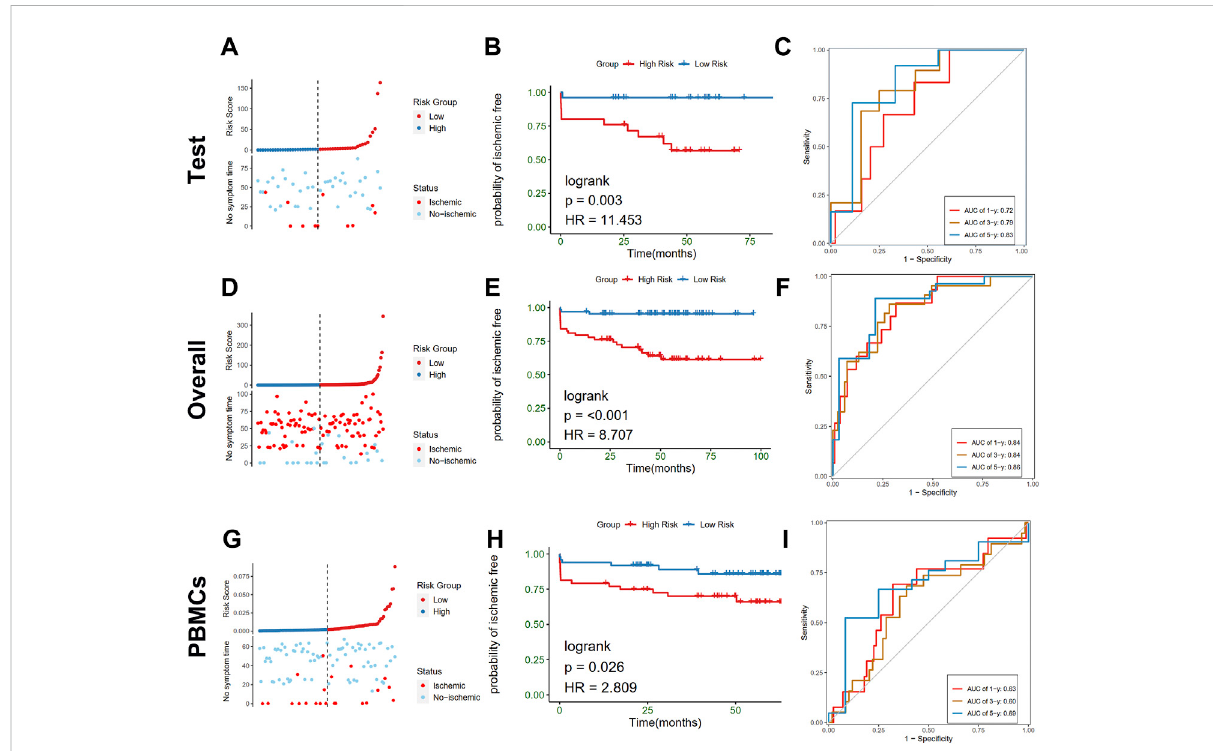
FIGURE 9 Validationoftheriskmodelintest,overall,andPBMCscohort. (A – C) Distributionofriskscore(up)andischemicstatus(down)ofatherosclerotic patients, survival curve, time-dependent ROC curve of the risk model of the atherosclerotic patients in the high and low-risk groups in test cohort, respectively. (D – F) Distribution of risk score (up) and ischemic status (down) of atherosclerotic patients, survival curve, time-dependent ROC curve oftheriskmodeloftheatheroscleroticpatientsinthehighandlow-riskgroupsintheoverallcohort,respectively. (G – I) Distributionofriskscore (up) and ischemic status (down) of atherosclerotic patients, survival curve, time-dependent ROC curve of the risk model of the atherosclerotic patients in the high and low-risk groups in PBMCs cohort,